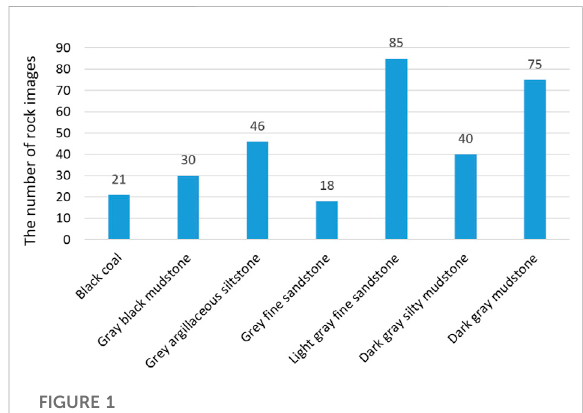
FIGURE 1 The speci fi c numbers of different rock